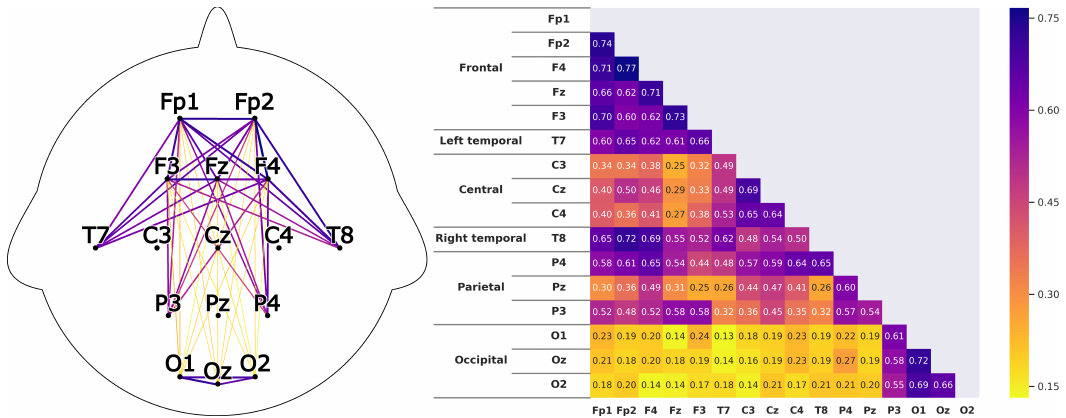
Figure 10. Correlations as described in Figure 8 for the HKT leader.